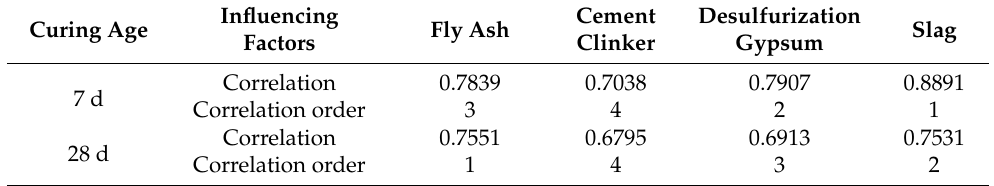
Table 1. Correlation between the age strength and the components of the cementitious material. Influencing Cement Desulfurization Curing Age Fly Ash Slag Factors Clinker Gypsum Correlation 0.7839 0.7038 0.7907 0.8891 7 d Correlation order 3 4 2 1 Correlation 0.7551 0.6795 0.6913 0.7531 28 d Correlation order 1 4 3